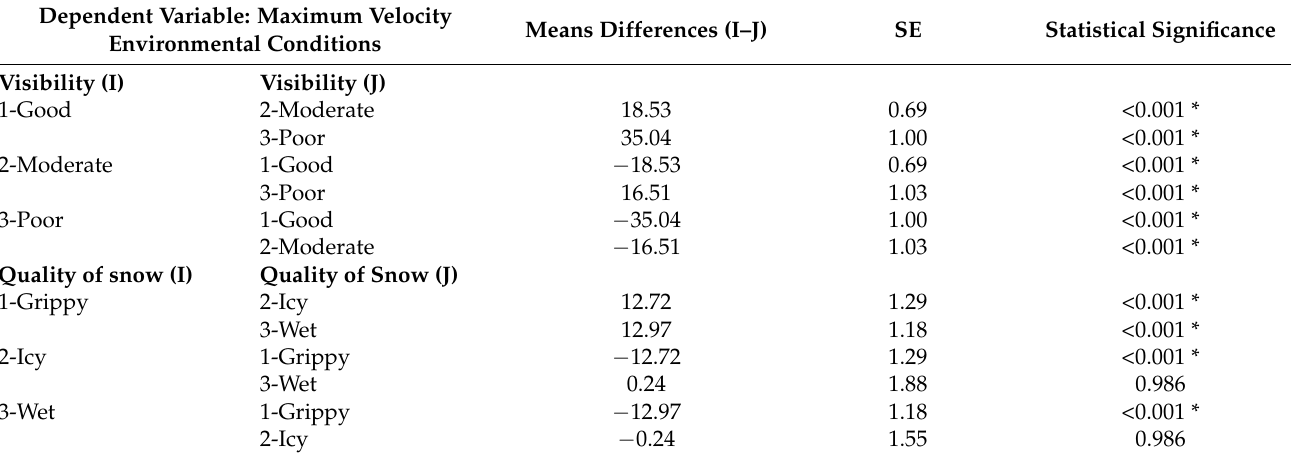
Table 4. Means differences of maximum velocity according to environmental conditions catego- ries.